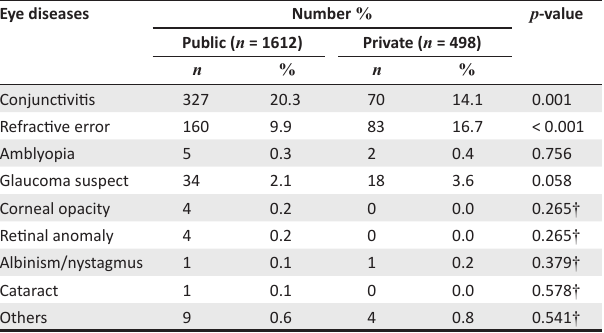
TABLE 3: Prevalence of eye diseases among children in public and private schools.